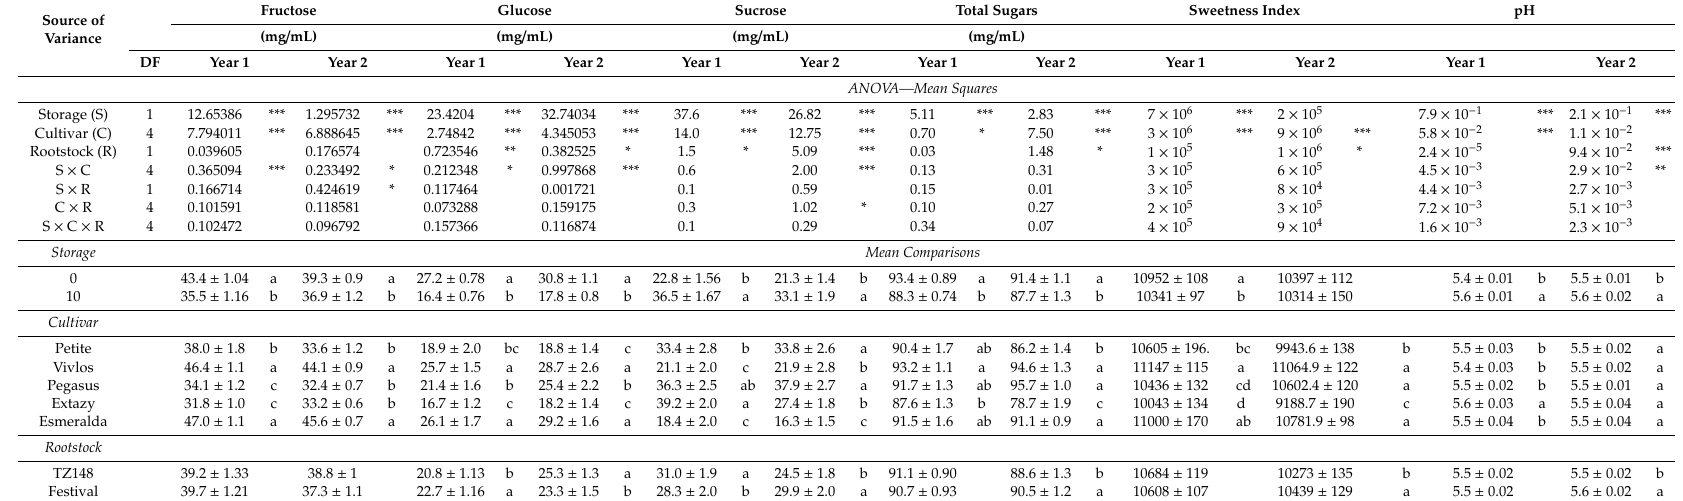
Table 3. Fructose, glucose, sucrose, total sugars, sweetness index and pH in watermelon fruit of cvs. Petite, Vivlos, Pegasus, Extazy and Esmeralda grafted on TZ148 and Festival rootstocks and stored for 10 days at 25 ◦ C. Values represent means ±